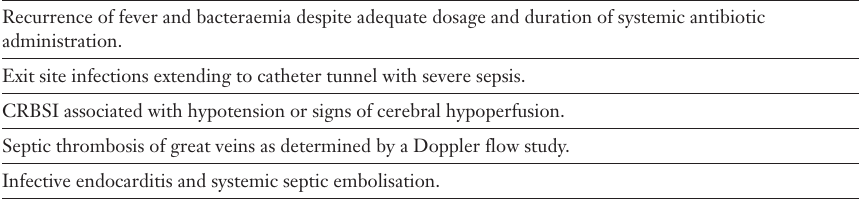
Suggested indica- tions for HD catheter removal *